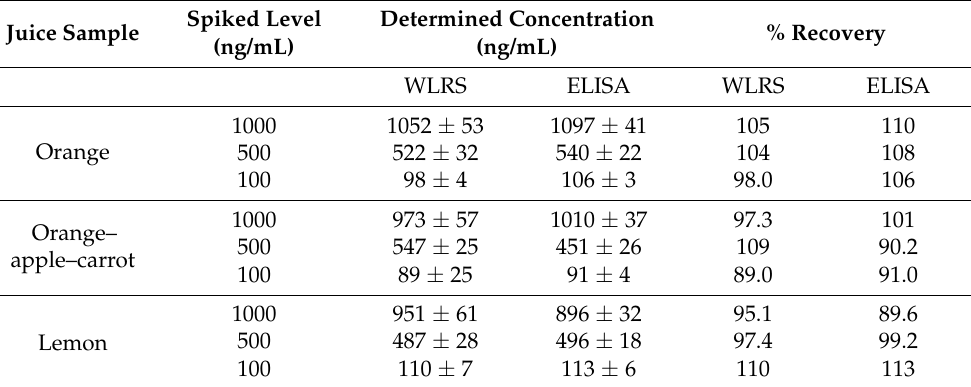
Table 1. Recovery values of carbendazim in commercial fruit juices spiked with the indicated concentrations of the pesticide.